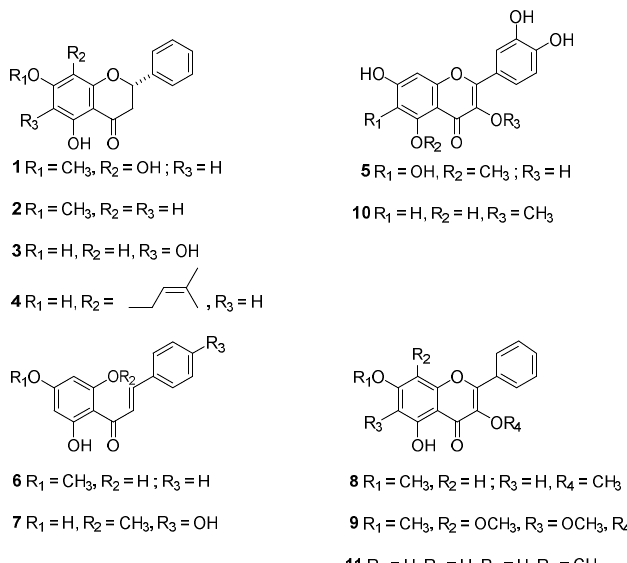
Figure 2. Chemical structures of the isolated compounds from H. cymosum ( 1 – 7 ) and H. pandurifolium ( 8 – 11 ).